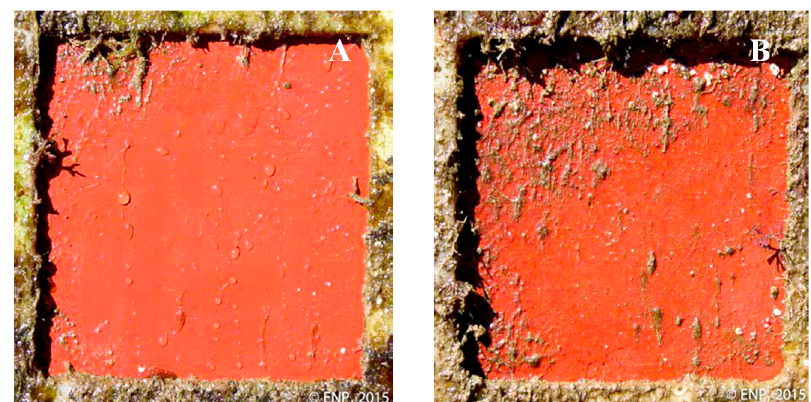
Figure 4. Silicone-based coatings with immobilised Econea biocide (<0.6 wt. %) ( A ) and reference ( B ) without biocide after 45 weeks (about 11 months) submerged in Atlantic sea at the pontoon of